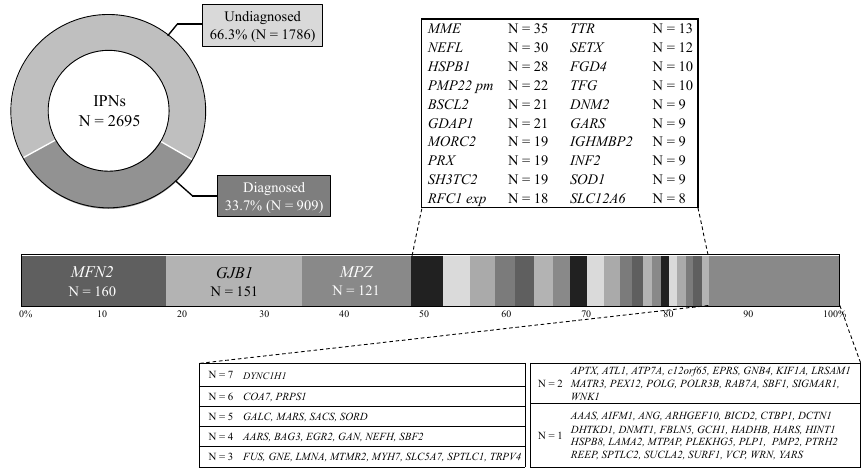
Figure 2. Genetic spectrum of IPNs in our Japanese case series. Pathogenic or likely pathogenic variants were identified in 909 (33.7%) cases among 2695 cases with suspected IPNs. pm: point mutation; exp: repeat expansion.